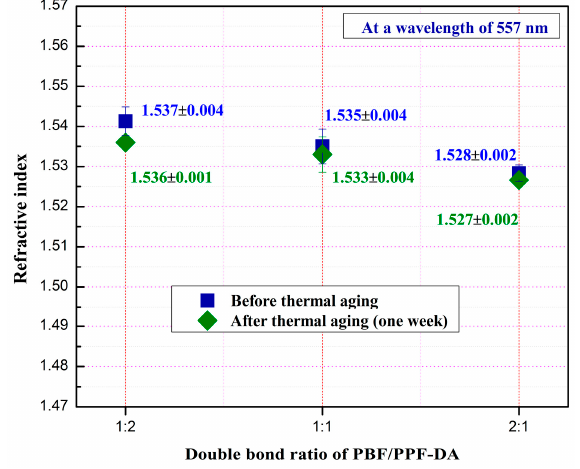
Figure 7. The refractive index of the prepared encapsulation material at a wavelength of 557 nm before and after thermal aging (one week).